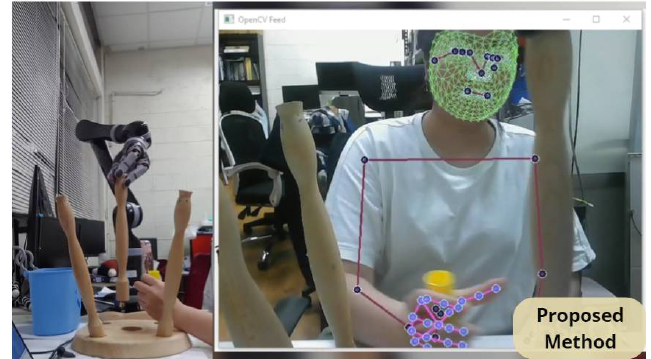
Figure 10. Facial and Skeletal Data Points on MediaPipe.